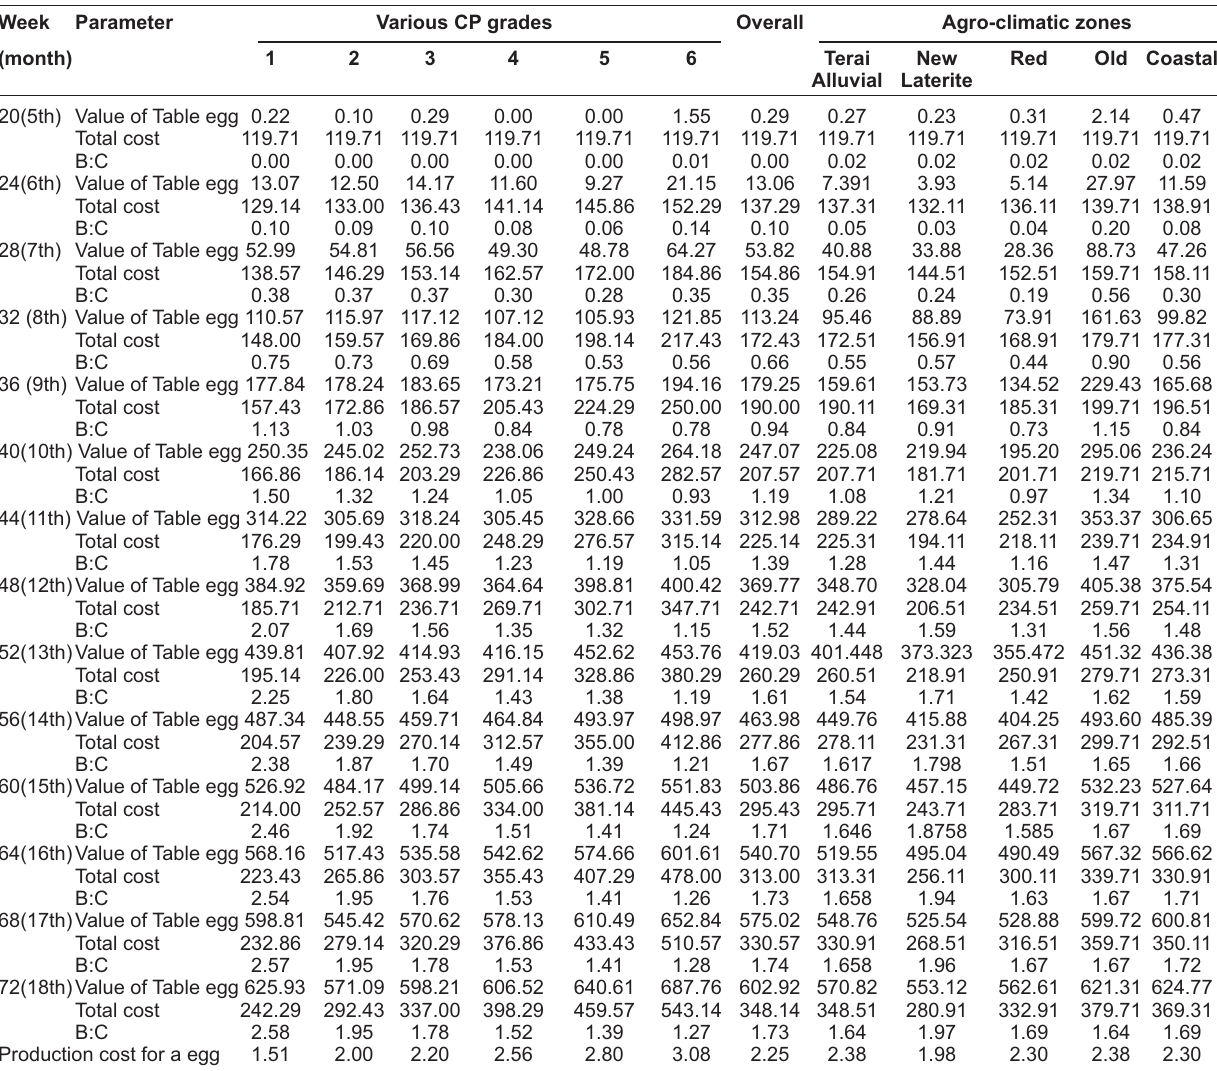
Table-4: Benefit-Cost analysis (B:C) of RIR chickens reared at backyard in different agro-climatic zones of West Bengal in respect of egg production. Week Parameter Various CP grades Overall Agro-climatic zones (month) 20(5th) Value of Table egg